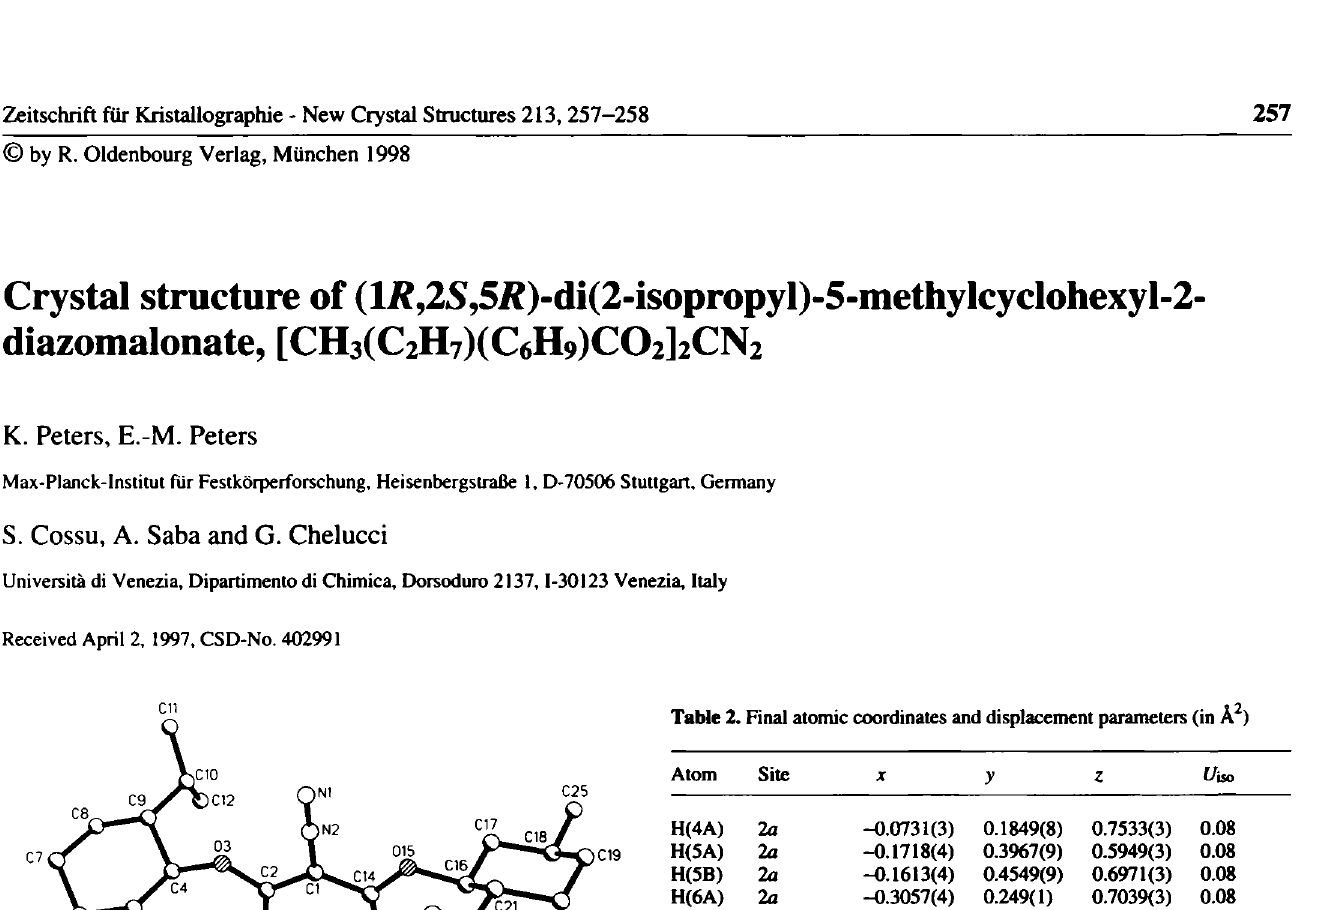
Table 1. Parameters used for the X-ray data collection Crystal: